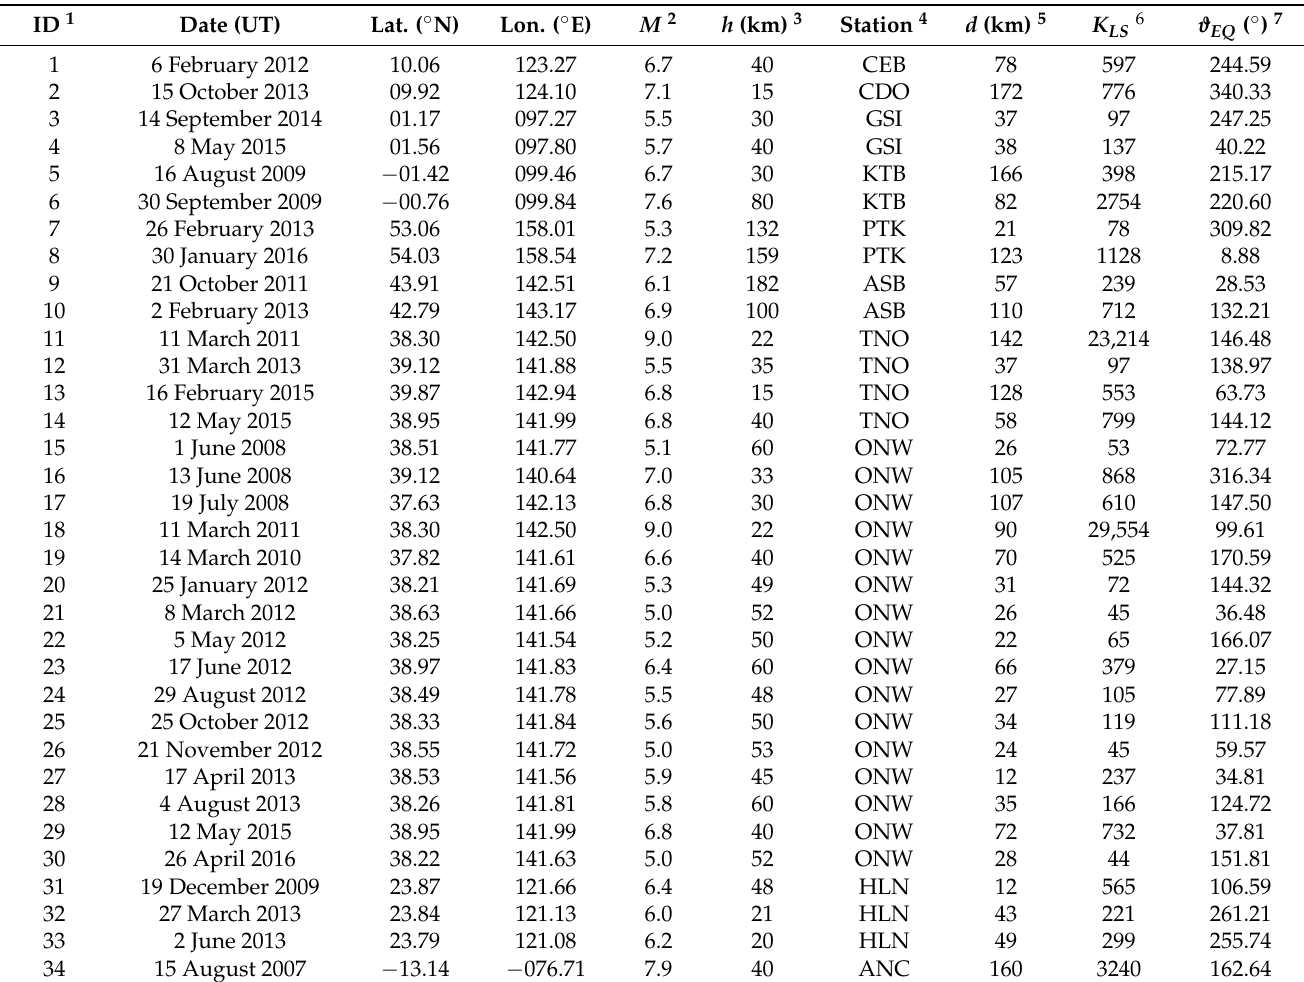
Table 2. Studied earthquakes and their